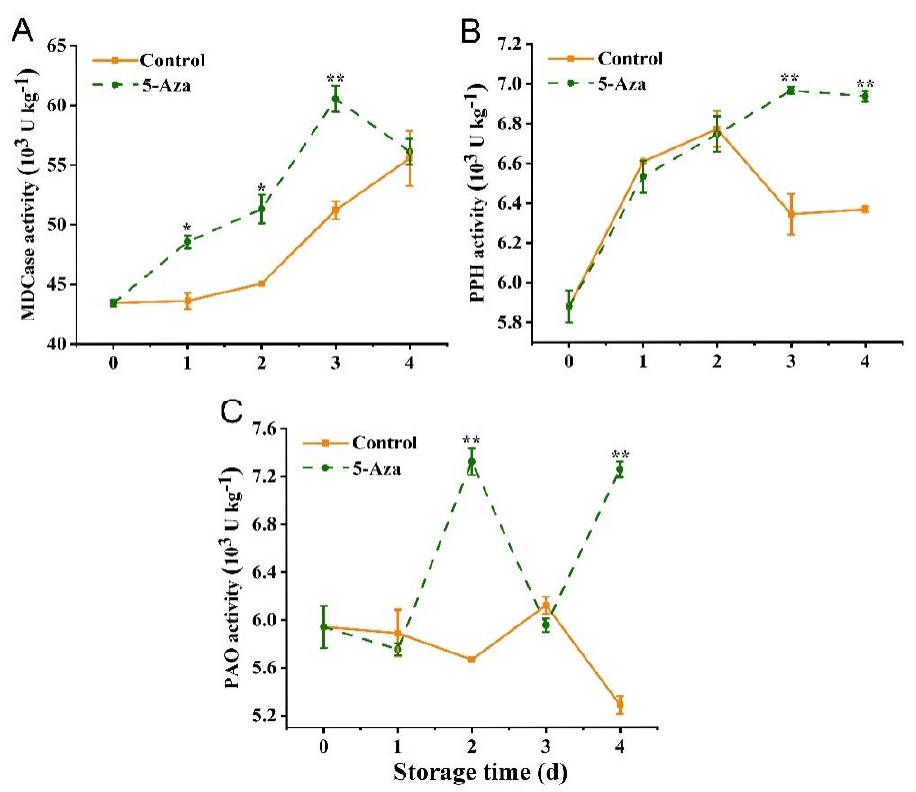
Figure 4. MDCase ( A ), PPH ( B ), and PAO ( C ) activities of pak choi in the treatment and control groups at 20 ± 1 °C. The data in the figure are the mean ± SD of three biological replicates. The asterisks in the figure indicate significant differences between the mean values of treatments and controls (* p < 0.05; ** p <